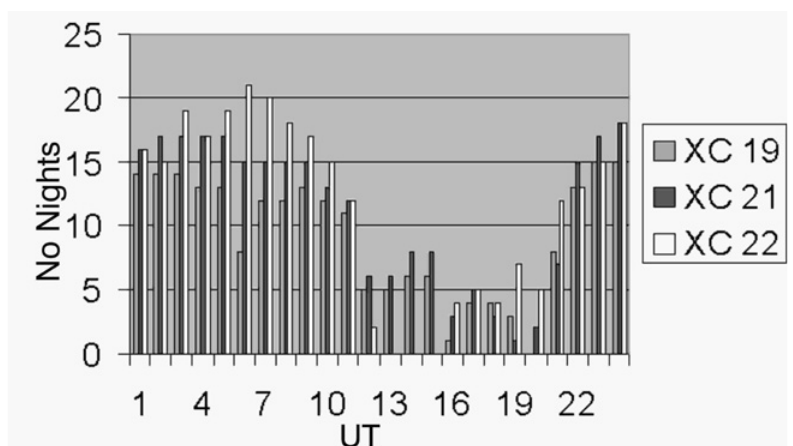
Fig. 4. The number of covered nights for the main targets in XCovs 19, 21 and 22 taken from the light curves presented in the WET campaign internet